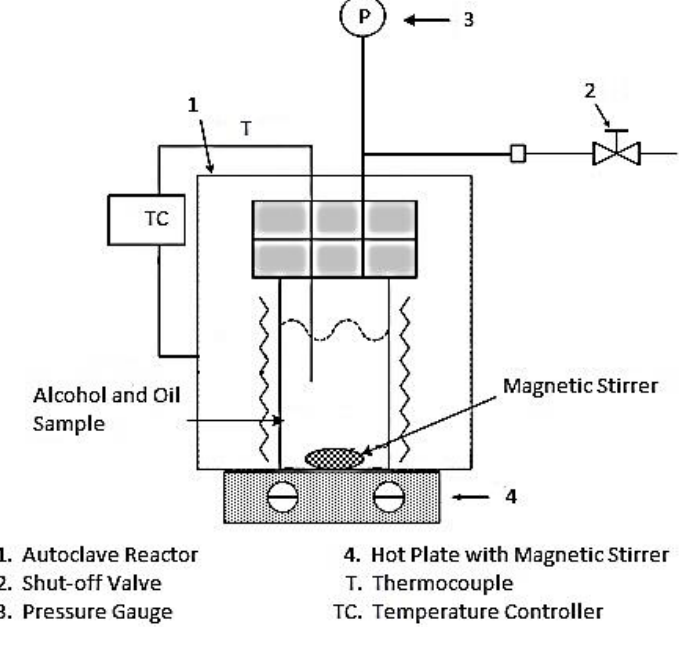
Figure 1. Schematic diagram of experimental